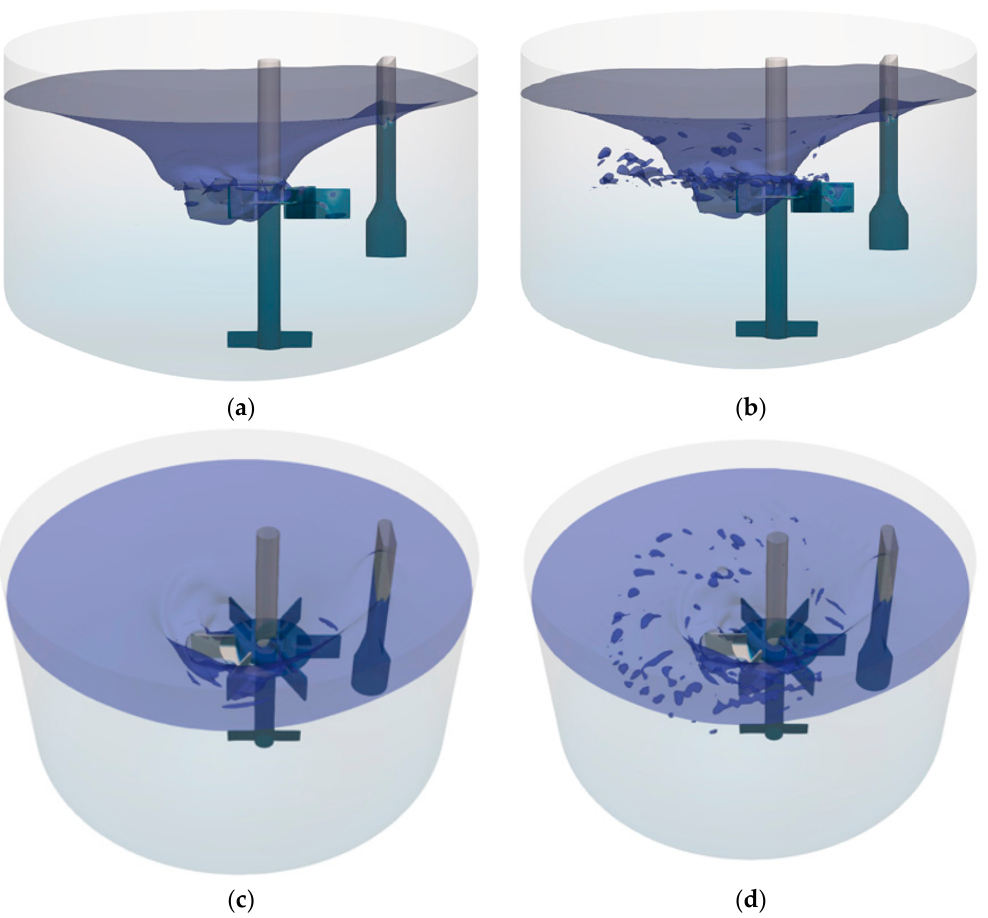
Figure 8. Surface flow visualisations (100 rpm, t = 90 s) using the time-averaged ( a , c ) and instanta- neous ( b , d ) fields of the solvent’s phase fraction ( α solvent =